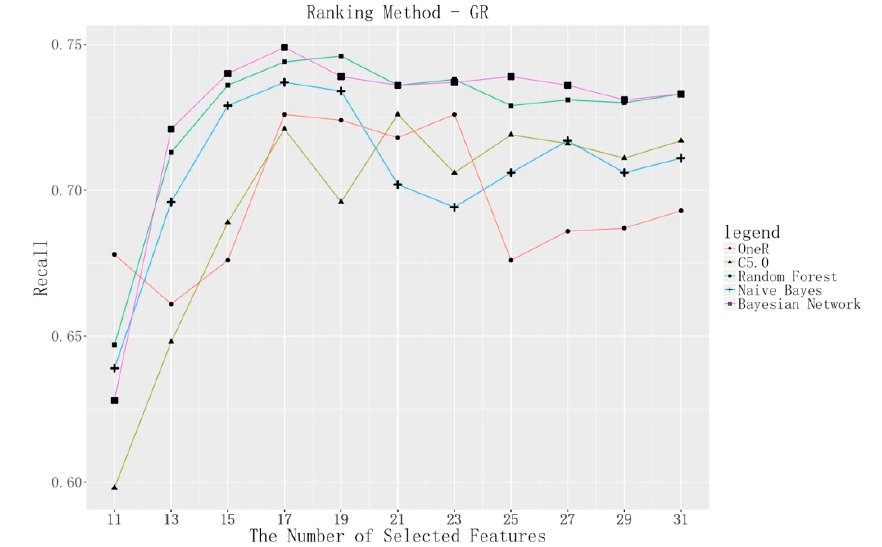
Figure 3. The classification results using the GR ranking method based on the Recall index.